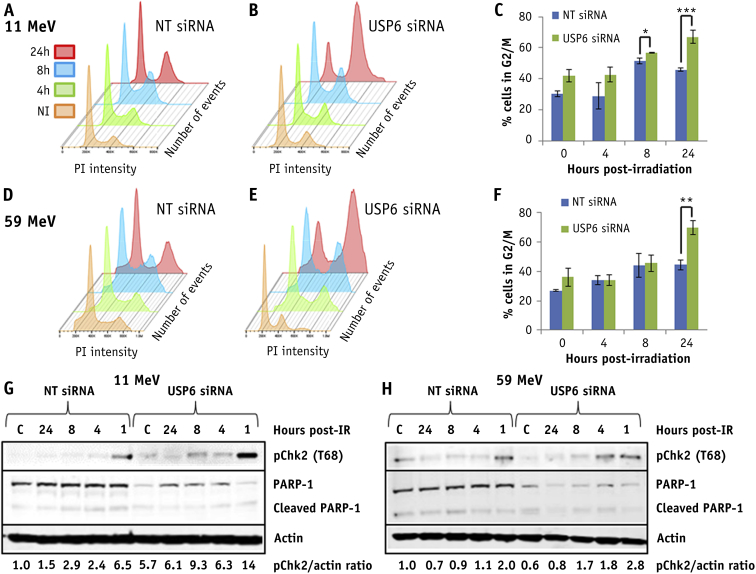
USP6 controls cell cycle progression in response to proton irradiation. HeLa cells were treated with USP6 (USP6_13) small interfering RNA (siRNA) or non-targeting control siRNA for 48 hours. At various time points after irradiation with 4 Gy (A-C) high linear energy transfer (LET) or (D-F) low-LET protons, cell cycle profiles were determined by fluorescence-activated cell sorting analysis. (C and F) Mean percentage of cells in G2/M phase ± standard error. *P < .05, **P < .02, ***P < .01 as analyzed by a 1-sample t-test. Cells were collected at various time points after irradiation with (G) high-LET or (H) low-LET protons, and whole cell extracts were analyzed by immunoblotting. Shown is the mean pChk2/actin ratio normalized to the levels of the untreated non-targeting control siRNA, which was set to 1.0.